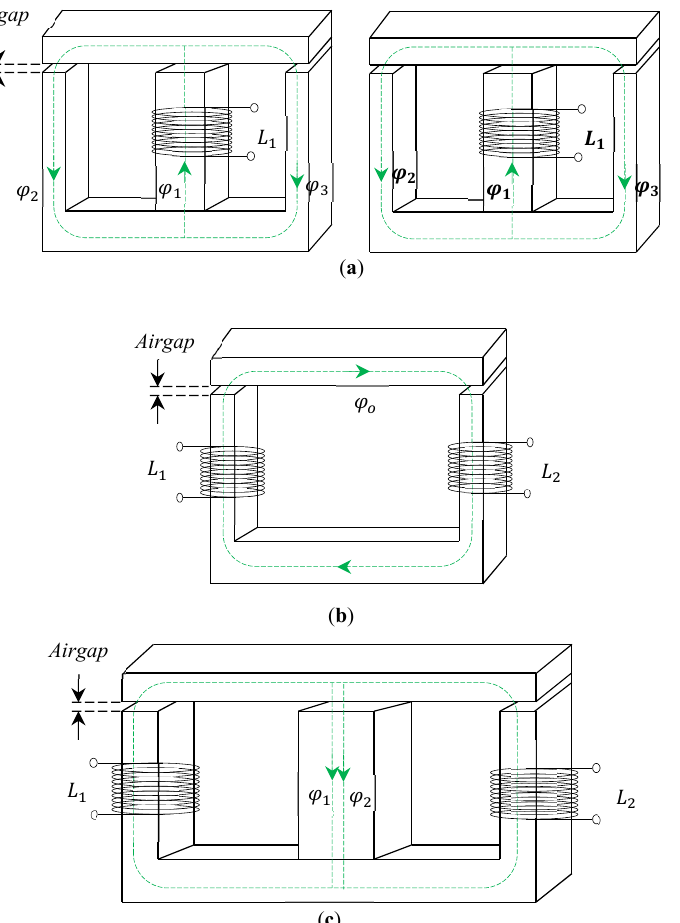
Figure 17. Integrated EI core inductor for DC-side filter inductor application ( a ) Two separate Inductors ( b ) Inductor Integrated by directing the flux in the middle leg ( c ) Inductor Integrated by directing the flux in the outer leg.